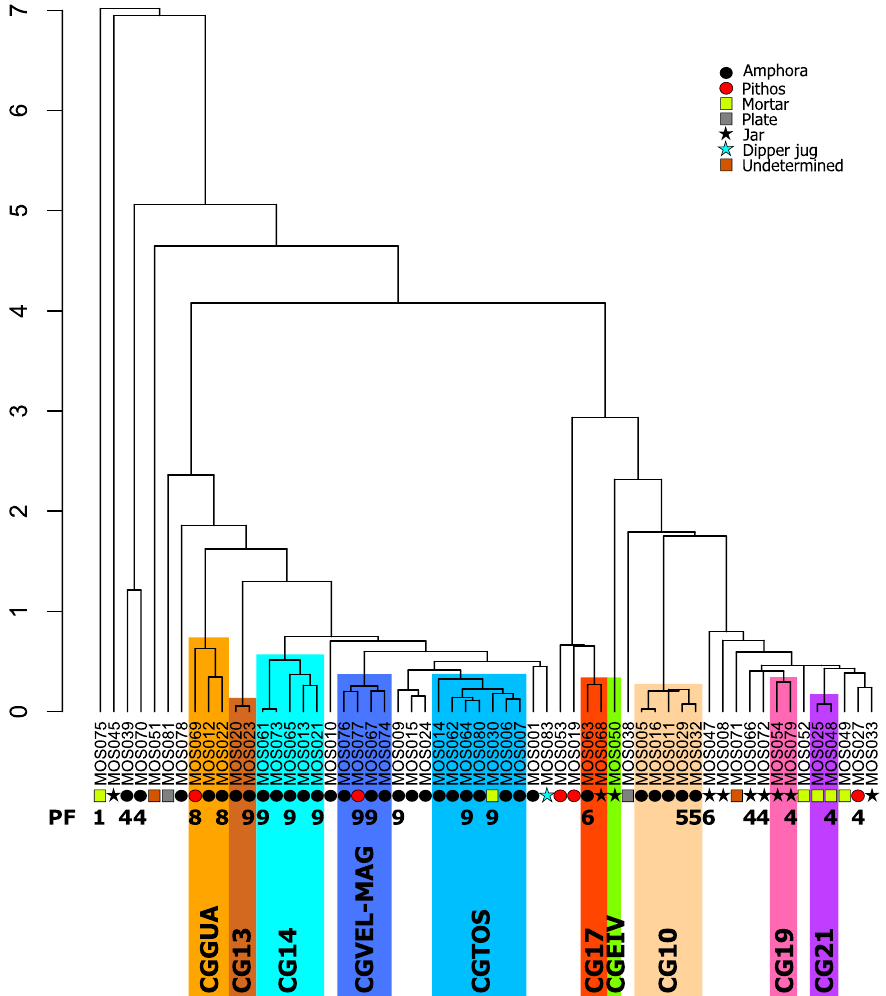
Figure 5. Dendrogram illustrating cluster analysis of the 58 individuals analysed, using the squared Euclidean distance and the centroid agglomerative algorithm, performed on the clr transformed components: Na 2 O, MgO, Al 2 O 3 , SiO 2 , K 2 O, CaO, TiO 2 , V, Cr, MnO, Fe 2 O 3 , Ni, Cu, Zn, Ga, Rb, Sr, Y, Zr, Nb, Ba, Ce, Pb, and Th. PF: petrographic fabric (post-analysis).